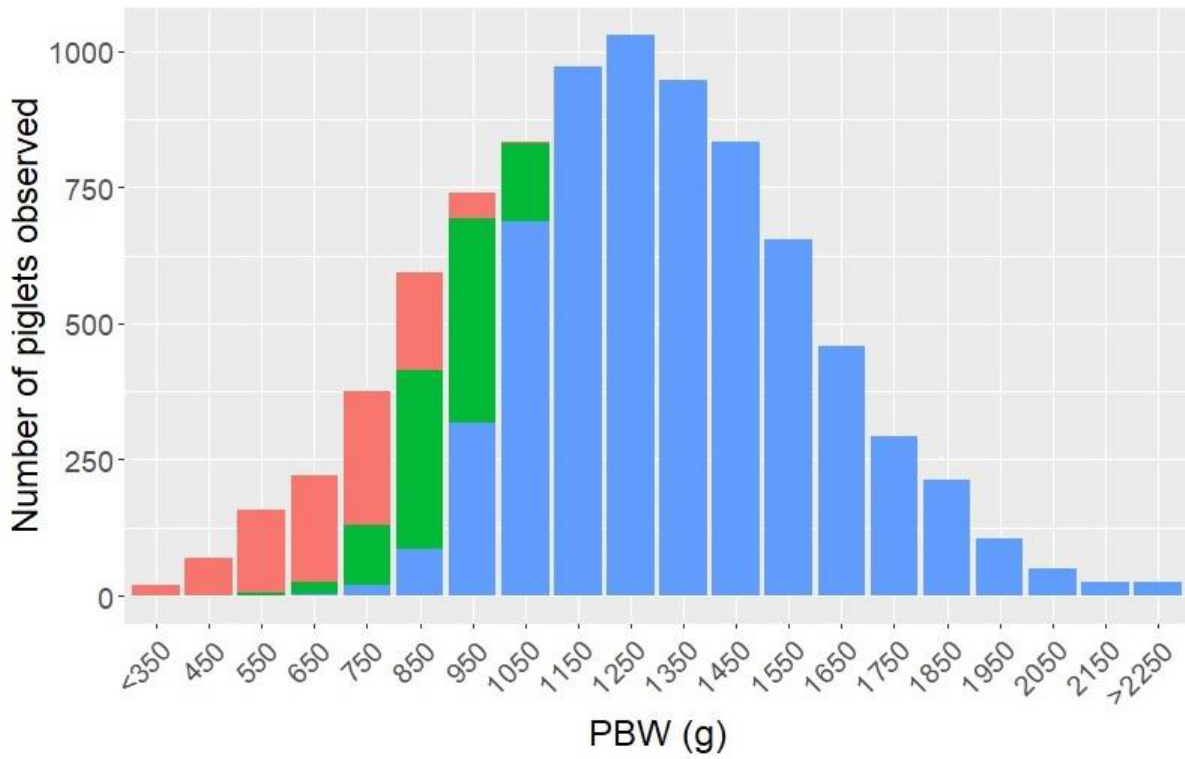
Figure 2. Number of liveborn piglets classified as normal (blue), mild IUGR (mIUGR (green)) and severe IUGR (sIUGR (red)), divided by birth weight intervals (PBW), where values on the x -axis cover ± 50 g. A weak negative correlation was found between CV PBW and the average PBW ( − 0.286; p < 0.001), and a positive correlation between CV PBW and litter size (0.265 p < 0.001), which is shown in Figure 3.